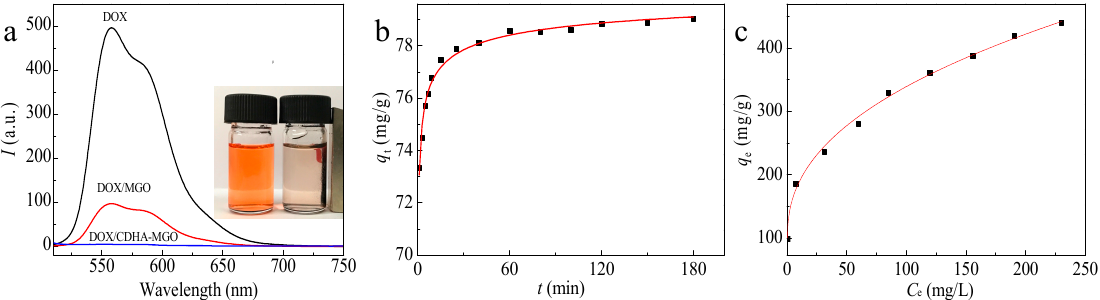
Figure 3. ( a ) The fluorescence spectra of 0.0025 mg/mL doxorubicin (DOX), the supernatant of DOX/MGO, and the supernatant of DOX/CDHA–MGO (inserts display the DOX (left) and DOX/CDHA–MGO by magnetic separation (right)); ( b ) adsorption kinetic curves of CDHA–MGO towards DOX (0.01 mg/mL) at pH 7.4; ( c ) adsorption equilibrium isotherm profiles for DOX on CDHA–MGO.